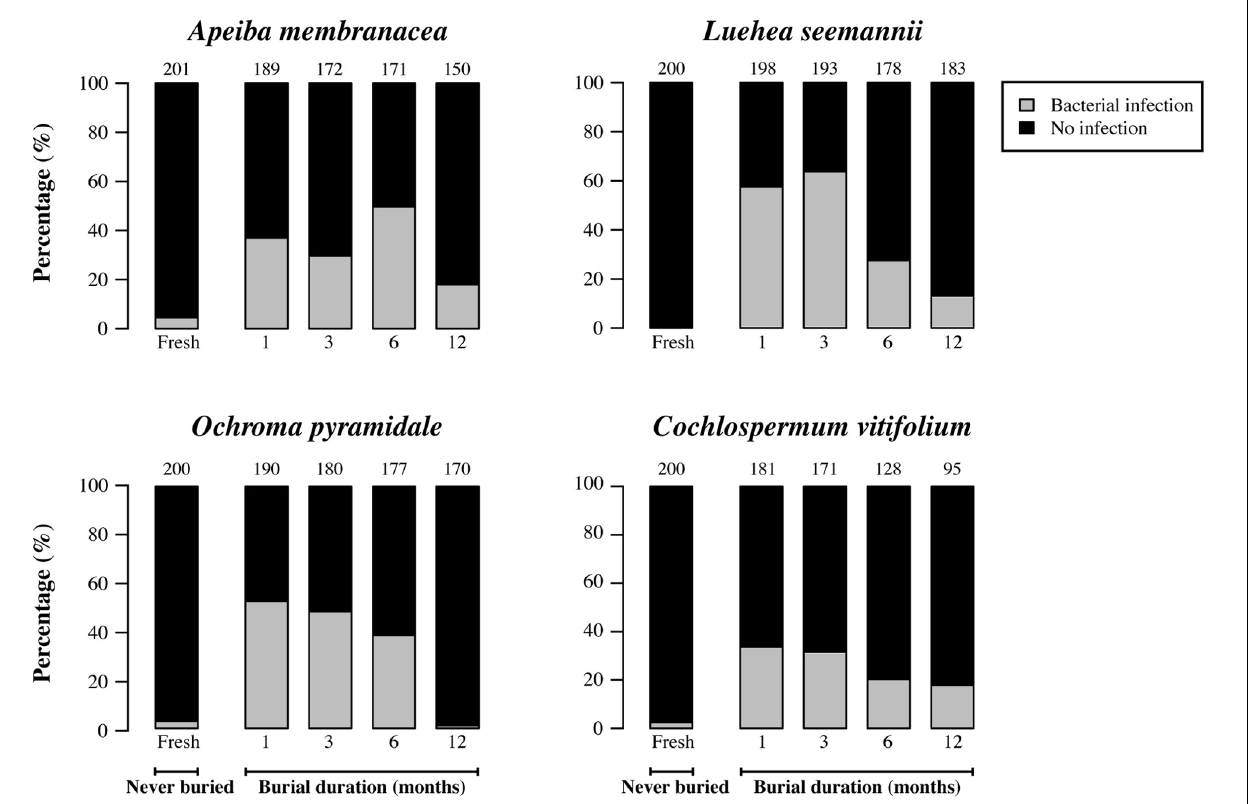
FIGURE 5 | Percentage of seeds infected by cultivable bacteria (gray) and seeds without detectable infection (black) for fresh (unburied) seeds, and seeds successfully recovered at different time intervals following burial. Numbers at the top of each bar